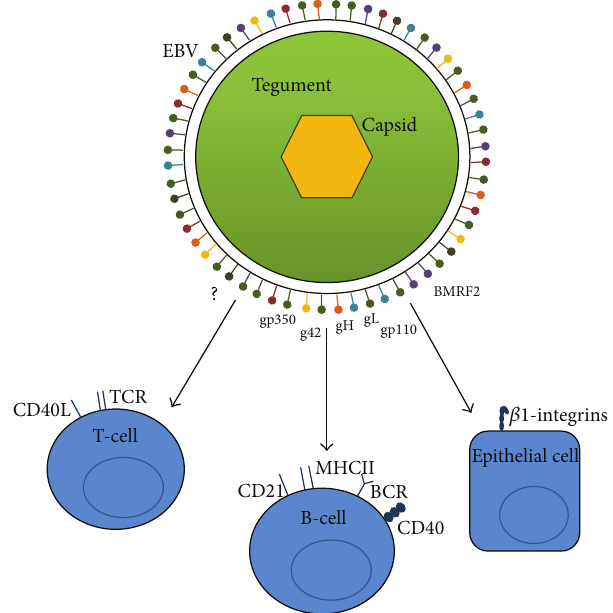
Figure 1: Epstein-Barr virus structure and infection of cells. Epstein-Barr virus (EBV) is comprised of a dsDNA genome inside an icosahedral capsid which is surrounded by the tegument and enclosed by a host cell membrane-derived envelope. During infec- tion with EBV, different envelope glycoproteins (gps) (shown in different colors) induce viral entry. During viral entry of B-cells, viral gp350 binds to type 2 complement receptor (CD21) on B-cells, and via a complex of gp42, gH, and gL, fusion of the cell membrane and the viral envelope is induced through (major histocompatibility complex) MHC II on the B-cell. During viral entry of epithelial cells, viral BMRF2 binds to 𝛽 1-integrins on the epithelial cell, and fusion of the membranes is facilitated by a complex of gH and gL. gp110 improves the efficiency of EBV to infect B-cells and epithelial cells. EBV can also infect T-cells; however, the mechanism of viral entry is unknown (?). BCR: B-cell receptor, TCR: T-cell receptor.